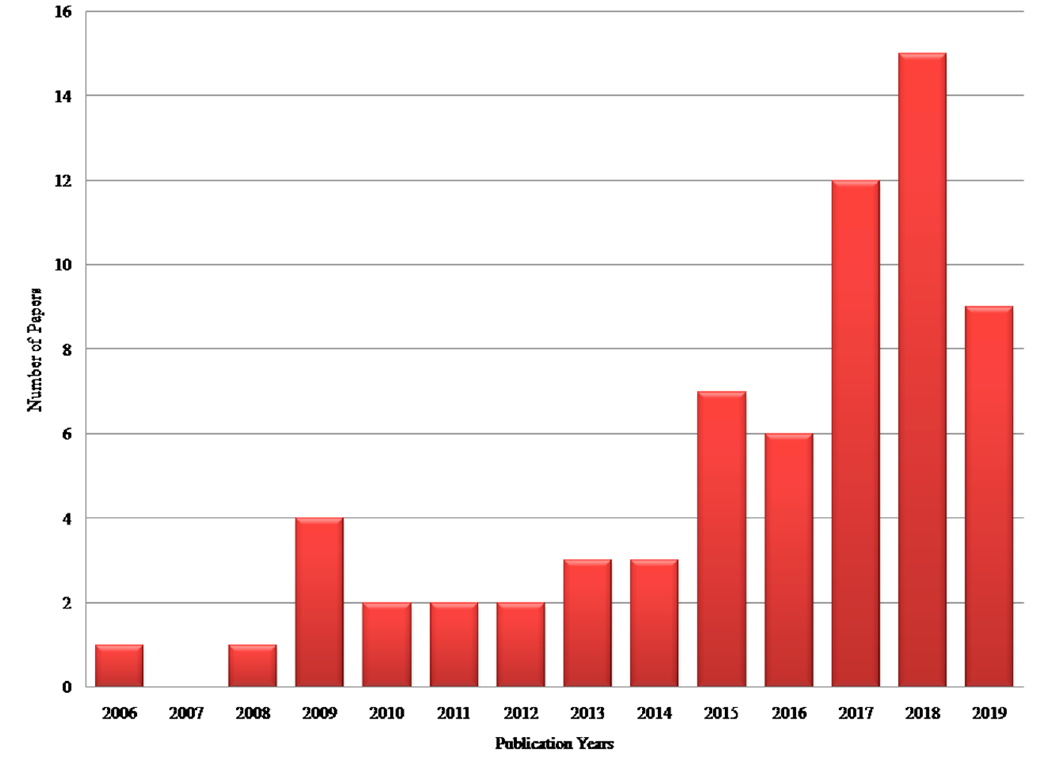
Figure 2. Distribution of selected papers by year.